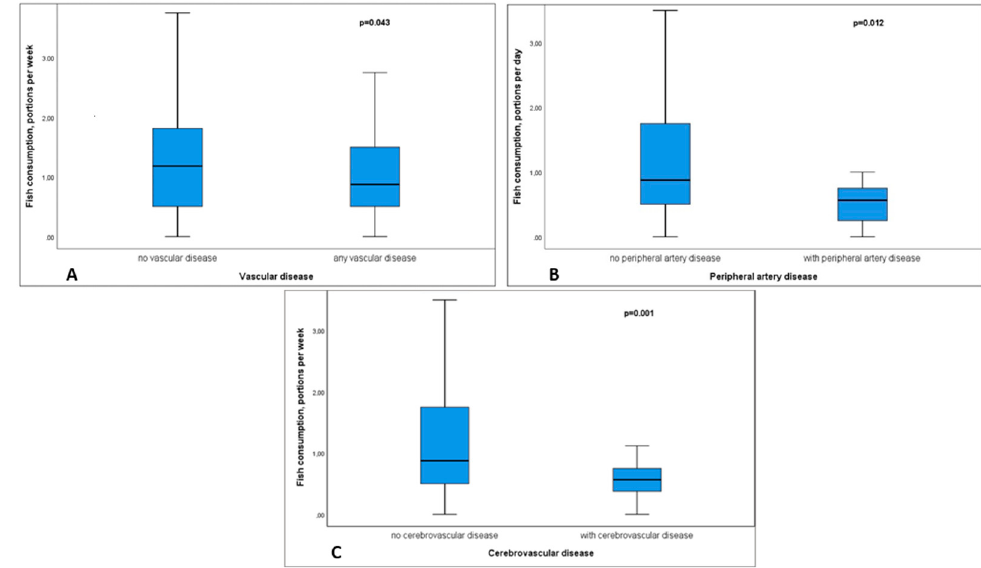
Figure 2. Boxplot diagram displaying differences in fish consumption per week between patients with and without vascular disease ( A ), peripheral artery disease ( B ) and cerebrovascular disease ( C ). The boxes show the median and interquartile range, while the whiskers are representative of the 95% confidence interval.